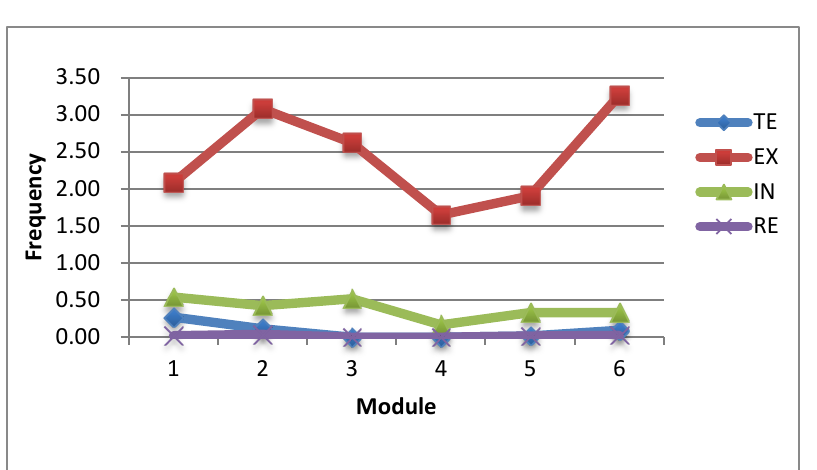
Figure 4. Average number and category of students’ cognitive presence posts in each module.